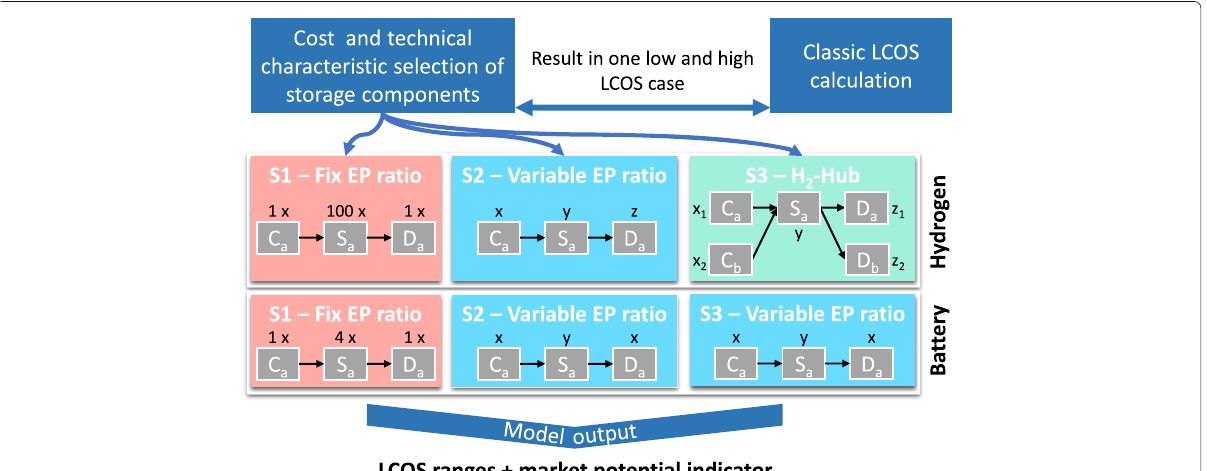
Fig. 5 Description of the three storage scenarios. The cost and technical storage parameters are chosen once and serve as input for all storage scenarios. Scenario 1 shows the fixed energy-to-power ratio of the hydrogen and battery unit a . In Scenario 2 and 3 all components can be freely scaled. However, the battery is constrained to the same charger to discharger ratio. Further, the ’ b ’ in the H 2 − Hub scenario indicates a new technology addition. A least-cost optimization is run with each scenarios, whose results are used to create the spatially resolved LCOS and market potential